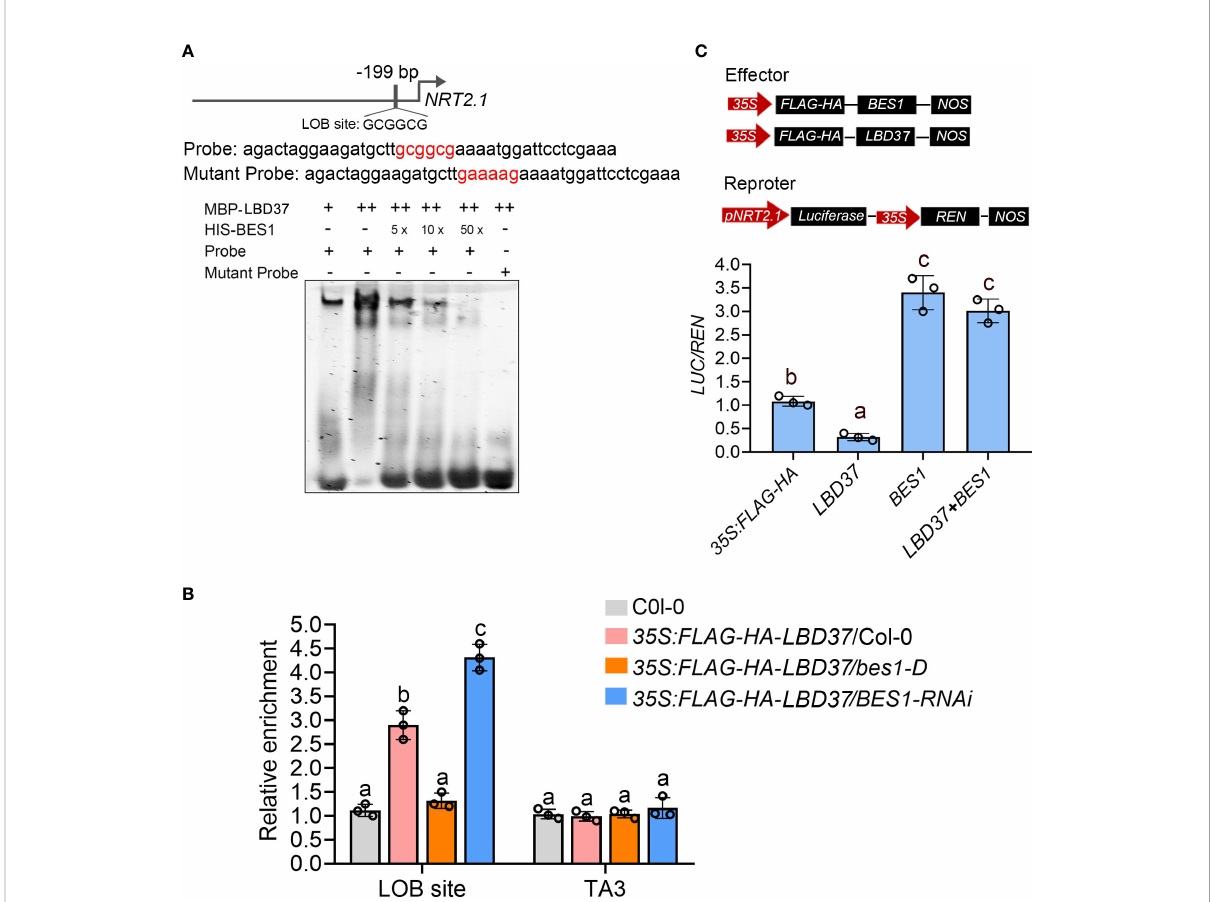
FIGURE 6 BES1 inhibits LBD37 binding to its target gene. (A) EMSA showing BES1 inhibits the DNA binding ability of LBD37. The top panel showed the DNA sequences used as DNA probe containing the normal or mutated form of LOB site (GCGGCG). The bottom panel showing LBD37 bind to NRT2.1 promoter and addition of BES1 with LBD37 suppresses the DNA binding ability of LBD37. (B) ChIP-qPCR assay showing BES1 inhibits LBD37 binding to LOB site in vivo . The wild-type (Col-0), 35S:FLAG-HA-LBD37/Col-0 , 35S:FLAG-HA-LBD37/bes1-D and 35S:FLAG-HA-LBD37/ BES1-RNAi were used to prepare chromatin and ChIP assay with anti-HA Agarose beads. The ChIP products were used to detect promoters containing LOB site. error bars represent standard deviations of three biological repeats and different Lowercase letters above the bars indicate statistically signi fi cant differences between samples (p < 0.05, two-way ANOVA). (C) The transient transcriptional assay showing BES1 inhibits the binding activity of LBD37 on NRT2.1 promoter. The top panel showed the structures of pNRT2.1:Luc and two effector constructs. BES1, LBD37 and REN are driven by 35S promoter. The bottom panel showed the LUC/REN ratio calculated by pNRT2.1:Luc relative to the REN activity. Error bars represent SDs of three biological repeats. Different Lowercase letters above the bars indicate statistically signi fi cant differences (p < 0.05) determined by one-way